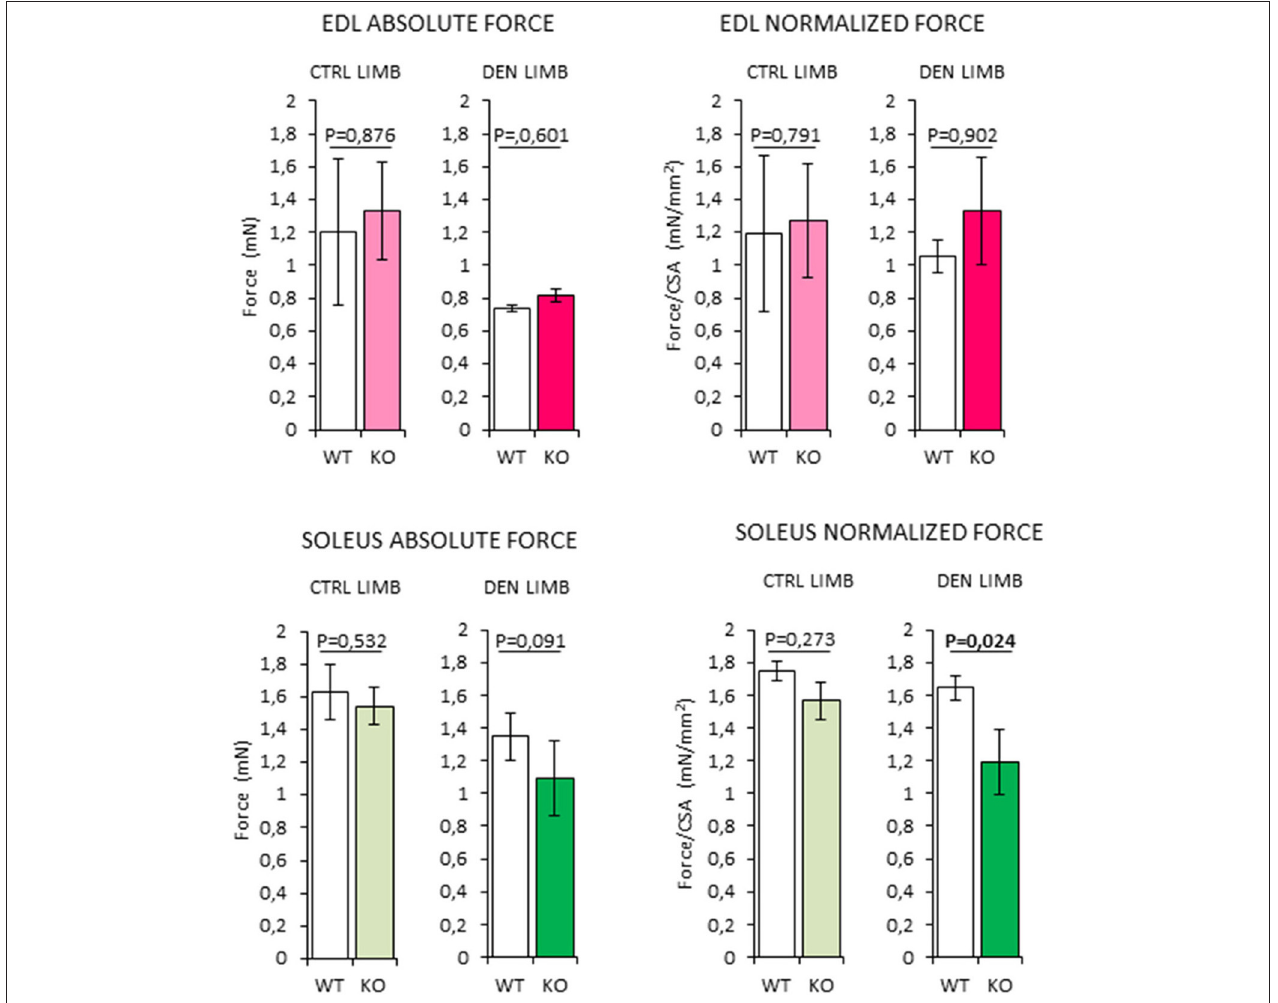
FIGURE 9 | Analysis of absolute and normalized force at tetanic contraction in excised extensor digitorum longus ( EDL ) and SOLEUS muscles, from contralateral non-denervated (CTRL) and denervated (DEN) limbs, in wild type (WT, N = 3) and Rxfp2 − / − mice (KO, N = 3). Data are reported as mean values ± standard error of the mean. Significance: P -values between compared conditions are reported. Significant differences ( P < 0.05) are highlighted in